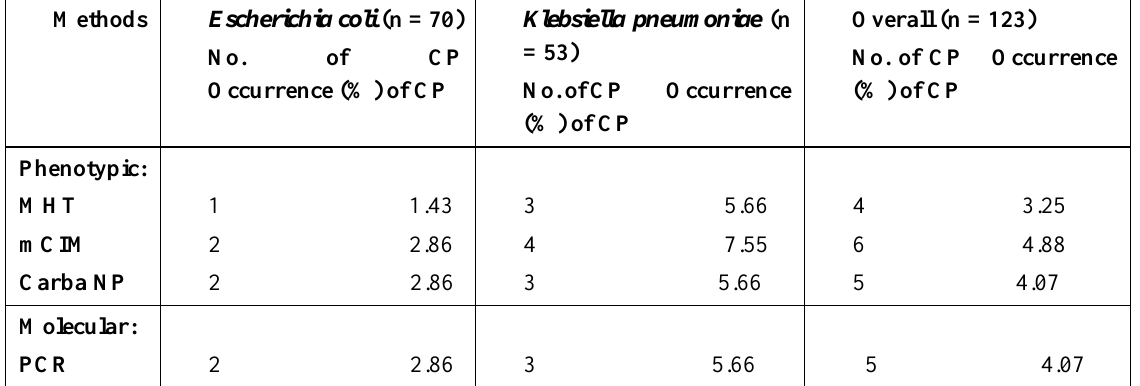
Table 3. Occurrence of Carbapenemase Producing Escherichia coli and Klebsiella pneumoniae based on the different detection